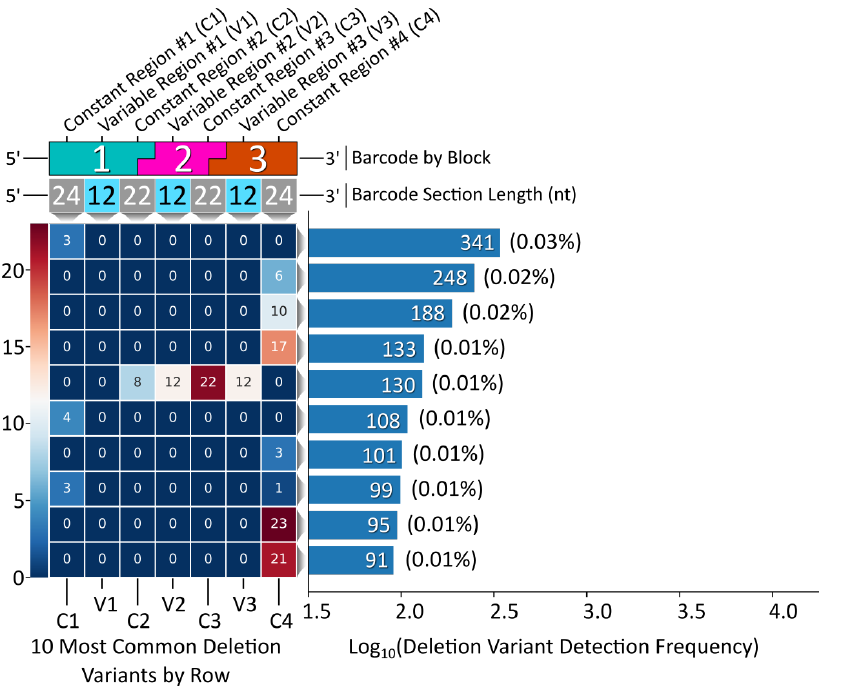
Figure 6. Gen_2 library deletion variant analysis. Left, a heatmap corresponding to the 10 most common deletion variants by row. Each block corresponds to a specific barcode domain displayed above the heatmap. Right, a histogram displaying the frequency of detection for each deletion variant out of the 1 M read subset. Table 4. Modular barcode sequences designating each block variant.